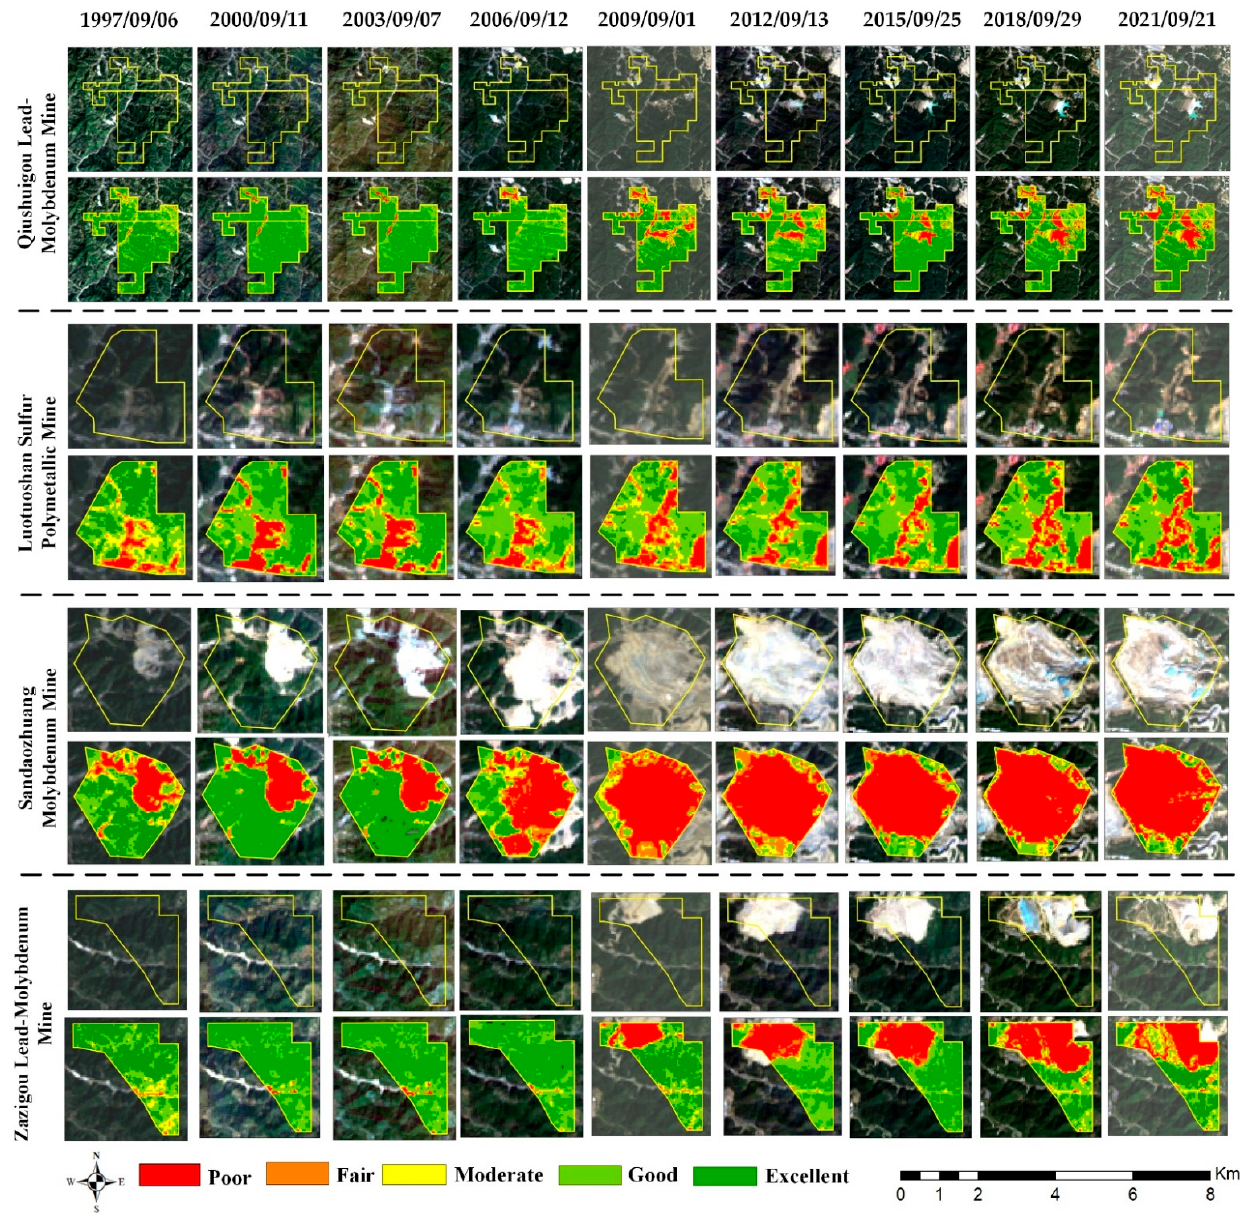
Figure 8. Ecological statuses for selected mining scopes in 1997, 2000, 2003, 2006, 2009, 2012, 2015, 2018, and 2021.